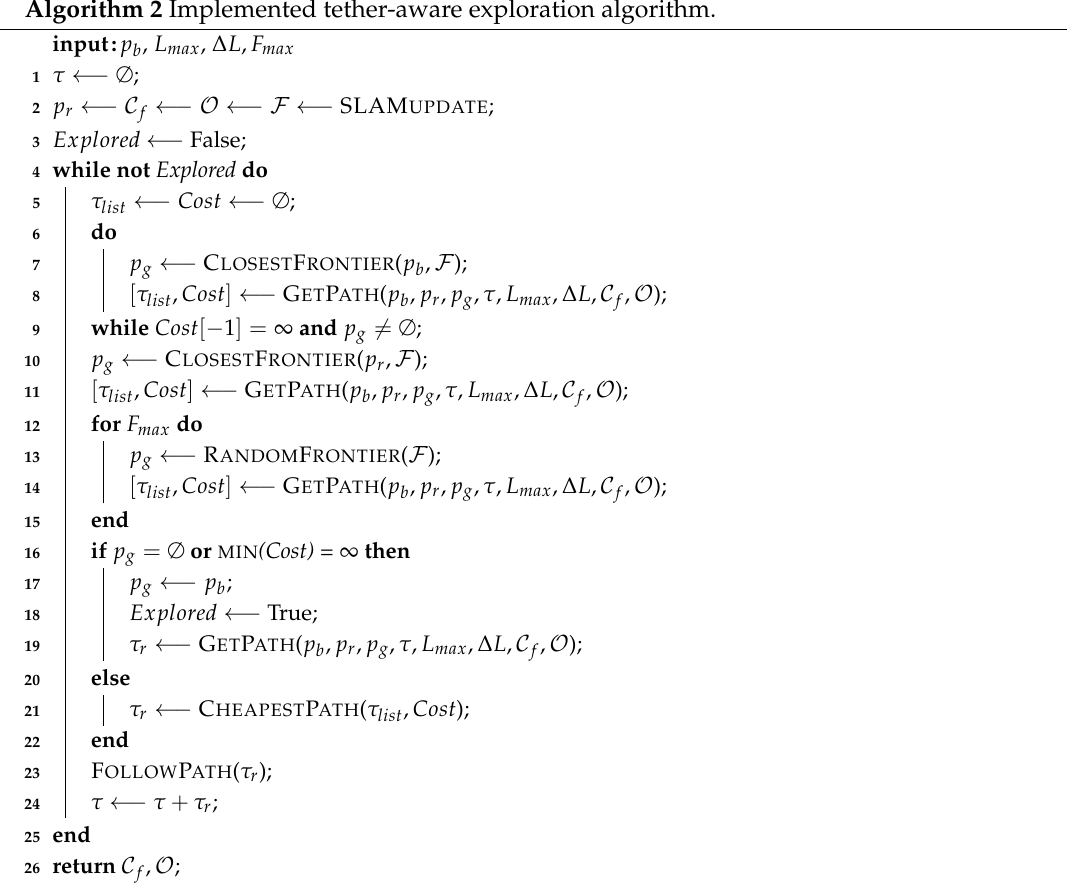
Algorithm 2 Implemented tether-aware exploration